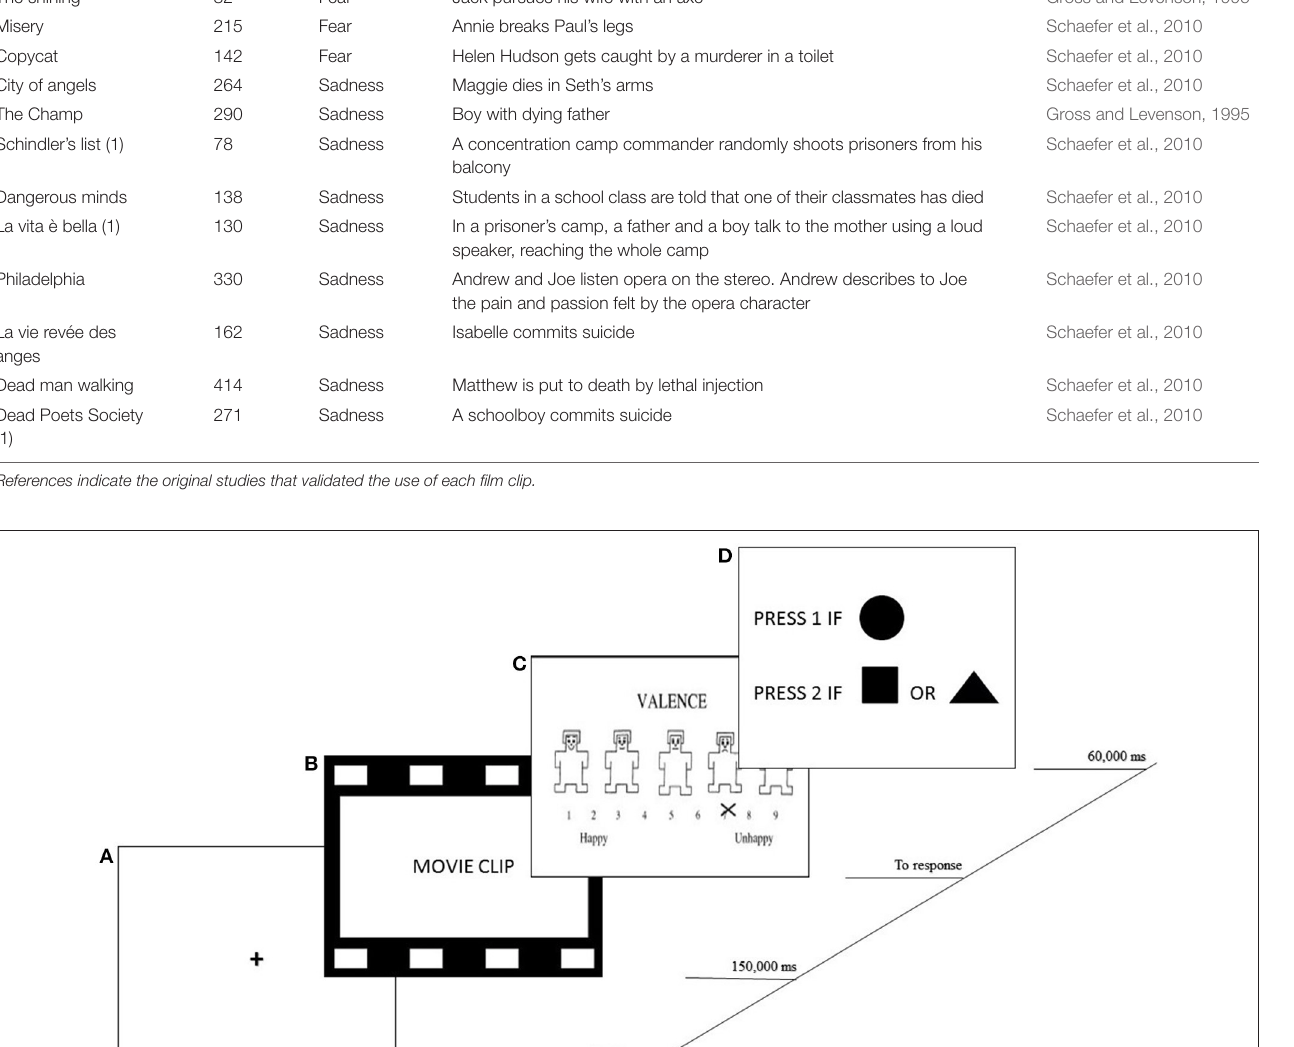
adults reporting higher negative affect on the PANAS affect scale, this variable was included as a covariate. Furthermore, as the previous literature describes gender-based differences